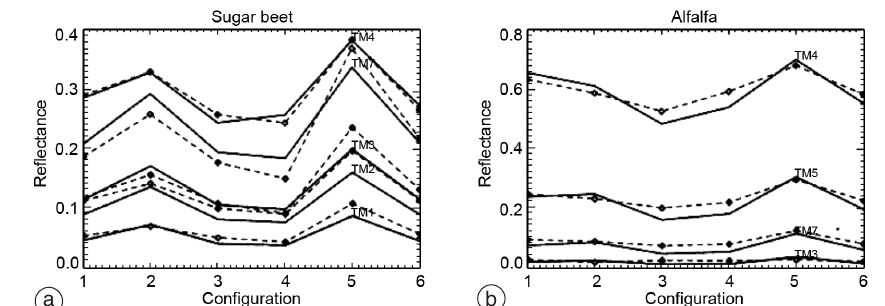
a Fig. 4a,b. Measured reflectance (dashed lines + symbols) and simulated (solid lines) at five different spectral channels over sugar beet (a) and alfalfa (b). Configurations 1-3 correspond to the N-S flight and 4-6 to the E-W flight. Within each flight line, consecutive numbers correspond to 8:00, 12:00 and 15:00 UTC, respectively. The figures show several examples of TM-like wavebands derived from real HyMap data.